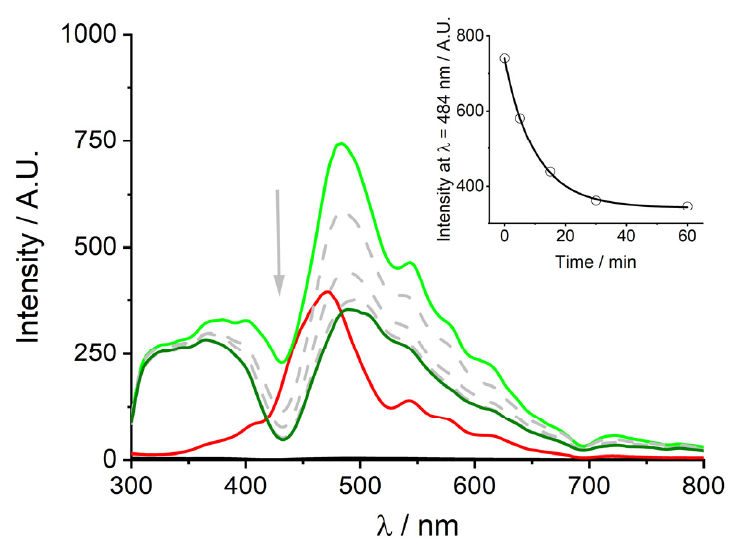
Figure 3. RLS spectra of t-H 2 Pagg aggregates (red curve), after addition of HSA at t = 0 s (light green curve) and at t = 60 min (dark green curve). Grey spectra and arrow indicate over time evolution. Inset: chance over time of the intensity at λ = 484 nm relative to the disassembling of t-H 2 Pagg aggregates. The black solid line represents the fit obtained with Equation (2) ( k = 0.0996 ± 0.0046 s − 1 , n = 0.95 ± 0.05). Experimental conditions: [t-H 2 Pagg] = 5 μ M, [NaCl] = 100 mM, [HSA] = 100 μ M, phosphate buffer 1 mM, pH = 7.4, T = 298 K.